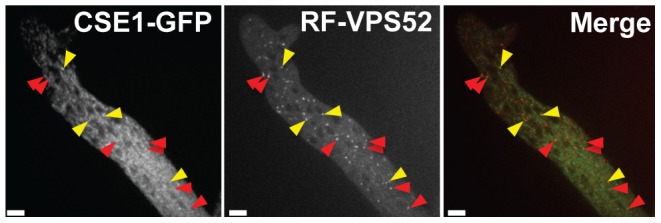
CSE1-GFP and RFP-VPS-52 colocalization.A heterokaryon between Δcse-1 (cse-1-gfp::his-3) A+rfp-vps-52::his-3 A showed co-localization of CSE1-GFP and the Golgi marker RFP-VPS-52 (yellow arrows). The red arrows indicate partial colocalization, likely due to cytoplasmic movement between frames. Scale bar = 5 µm.